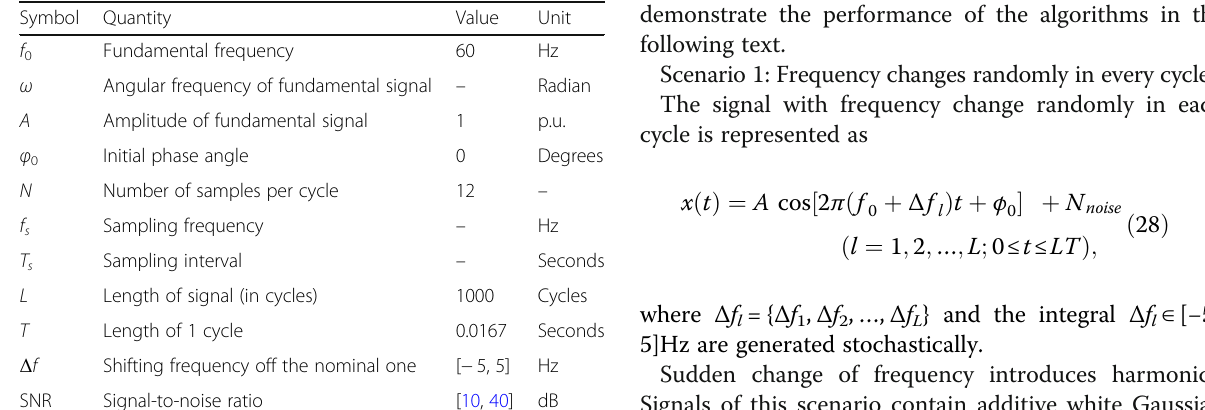
Table 1 Parameters used in simulation